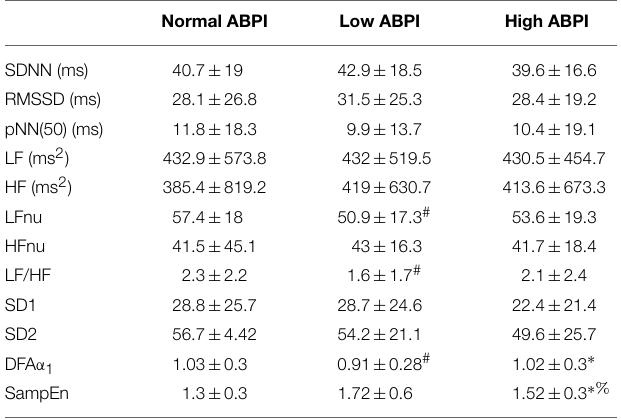
TABLE 2 | Differences in measured blood chemistry between those with normal, low and high ABPI. Normal ABPI